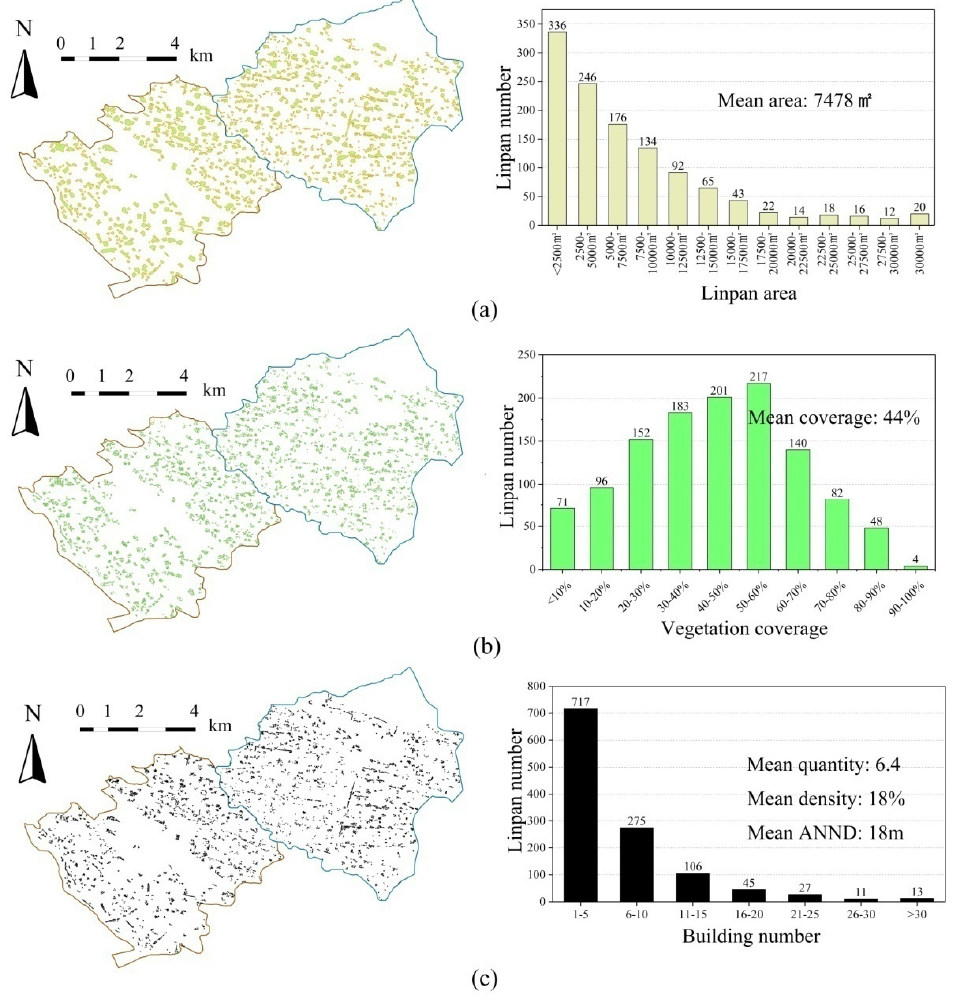
Figure 6. Linpan area, vegetation coverage, building number, density, ANND statistical results. ( a ) Linpan main body area statistics; ( b ) Linpan vegetation coverage statistics; ( c ) The statistics of build- ing number, mean building density and mean ANND in 1194 Linpan.